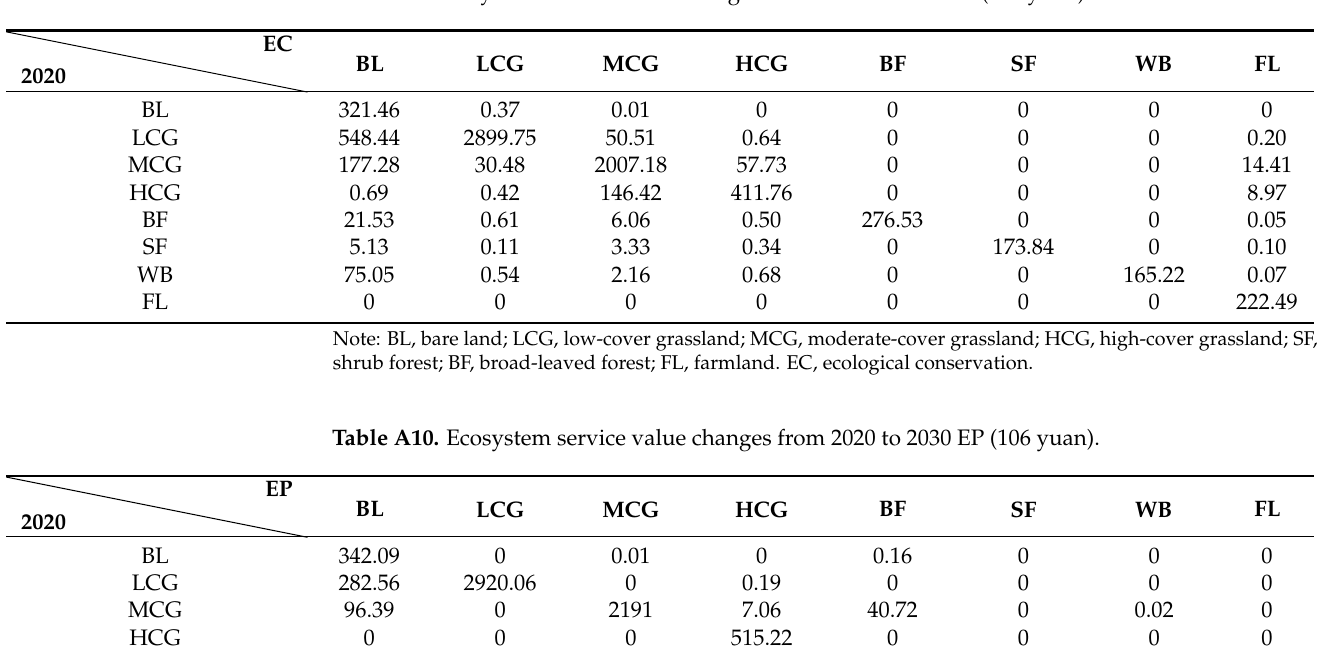
Table A9. Ecosystem service value changes from 2020 to 2030 EC (106 yuan).